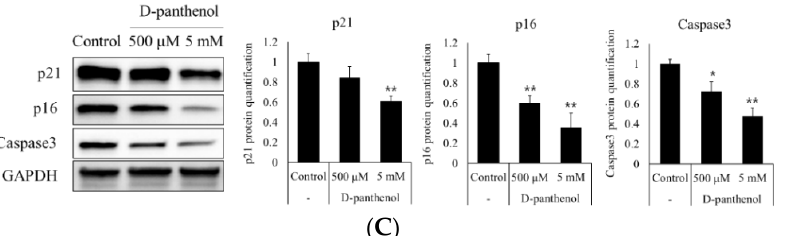
Figure 2. D-panthenol reduced apoptosis and senescence markers in cultured hDPCs. ( A ) mRNA expression levels of caspase 3, caspase 9 in hDPCs after 24 h treatment of D-panthenol. ( B ) mRNA expression levels of senescence markers (p21, p16) after 24 h treatment of D-panthenol. ( C ) Protein levels of p21, p16 and caspase 3 were analyzed by Western blot and quantitated. * p < 0.05, ** p < 0.01 versus control group. Data are expressed as mean ± SD.